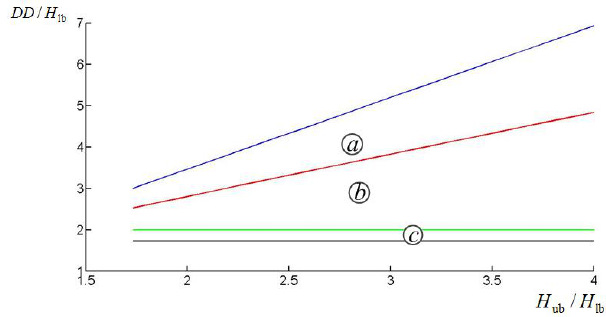
Figure 8. Ranges of three categories of type